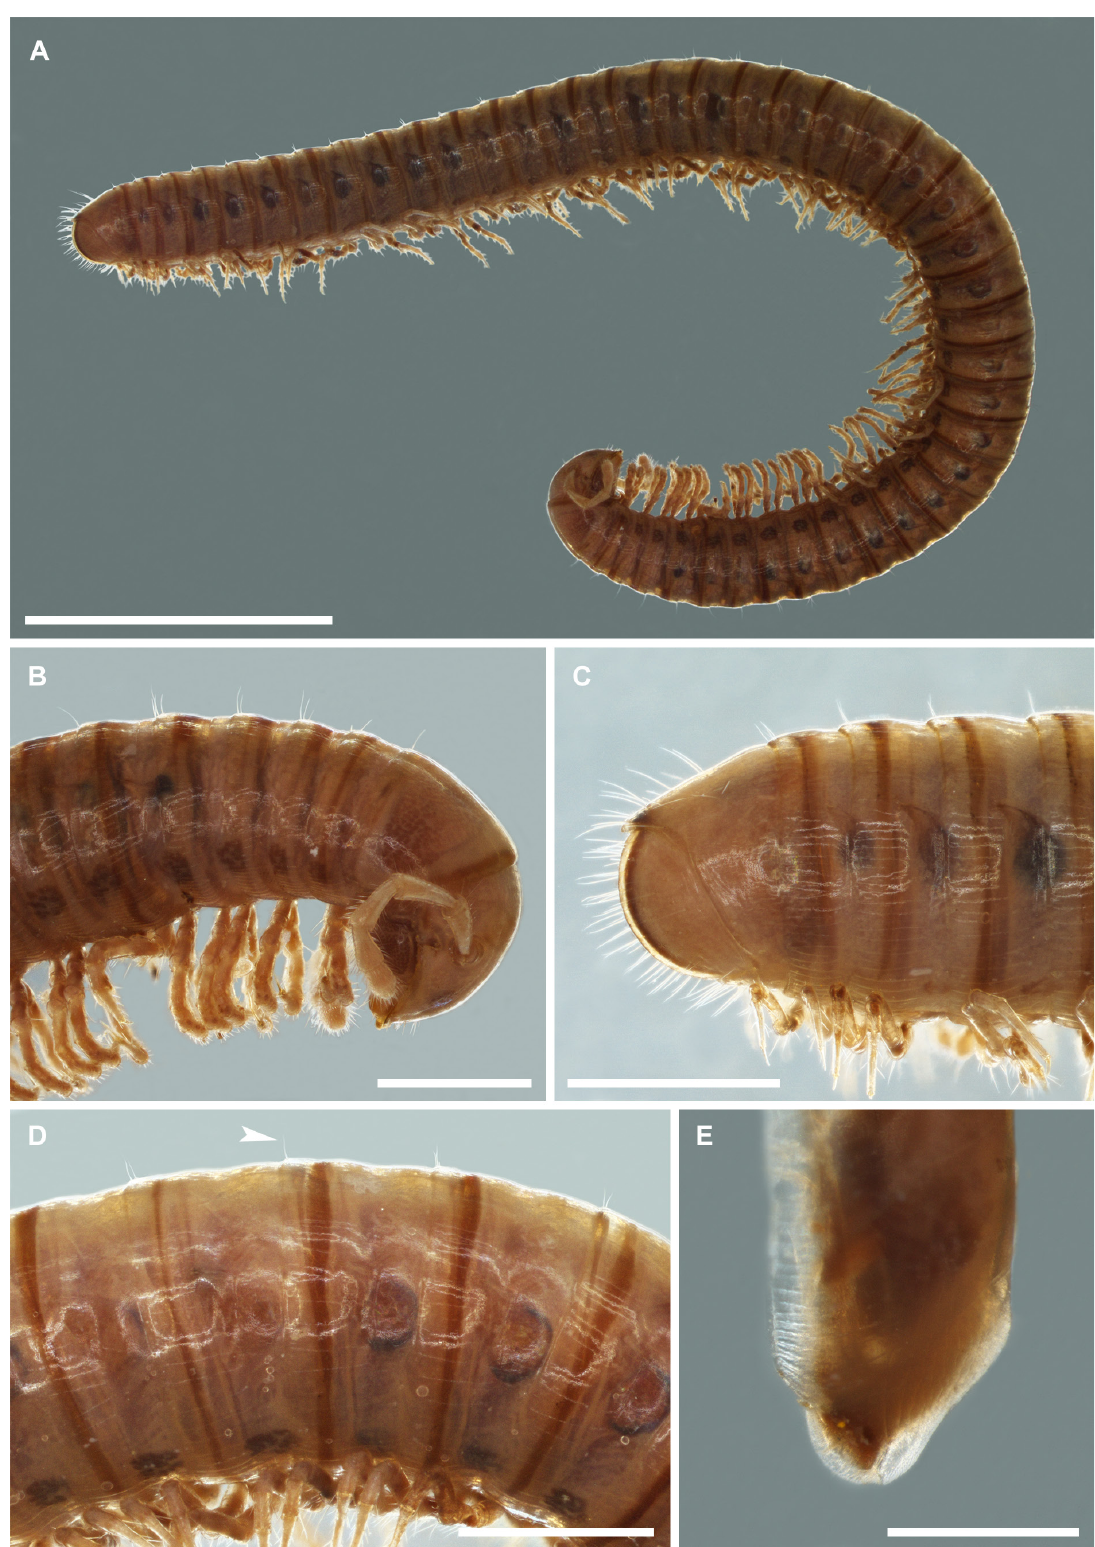
Fig. 32. Leucogeorgia prometheus sp. nov., paratype ♂ from Prometheus Cave (IZISU). A . Habitus, lateral view. B . Anterior part of body, lateral view. C . Posterior part of body, lateral view. D . Midbody rings, lateral view. E . Body ring 7, lateral view. Scale bars: A = 5 mm; B–D = 1 mm; E = 0.5